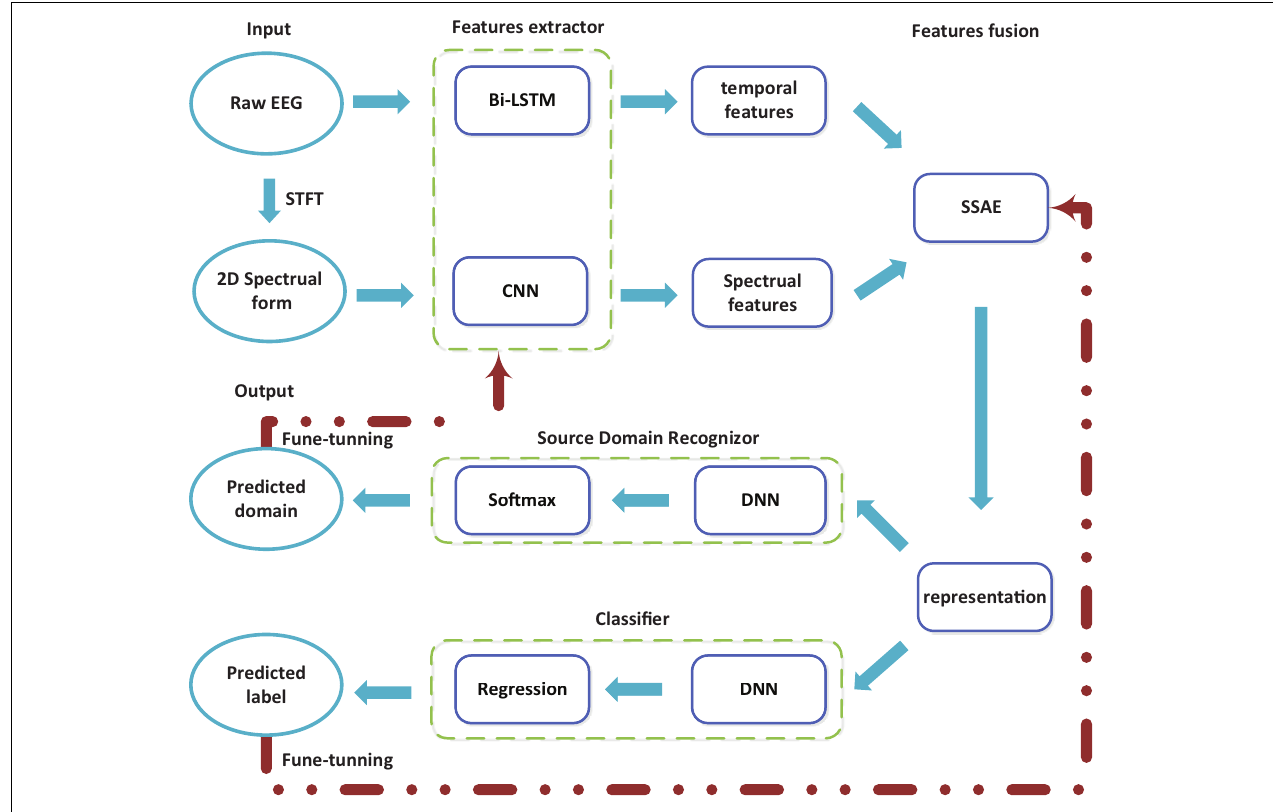
FIGURE 2 | Schematic overview of the proposed multi-hierarchical discriminative deep learning (MDDL) method.